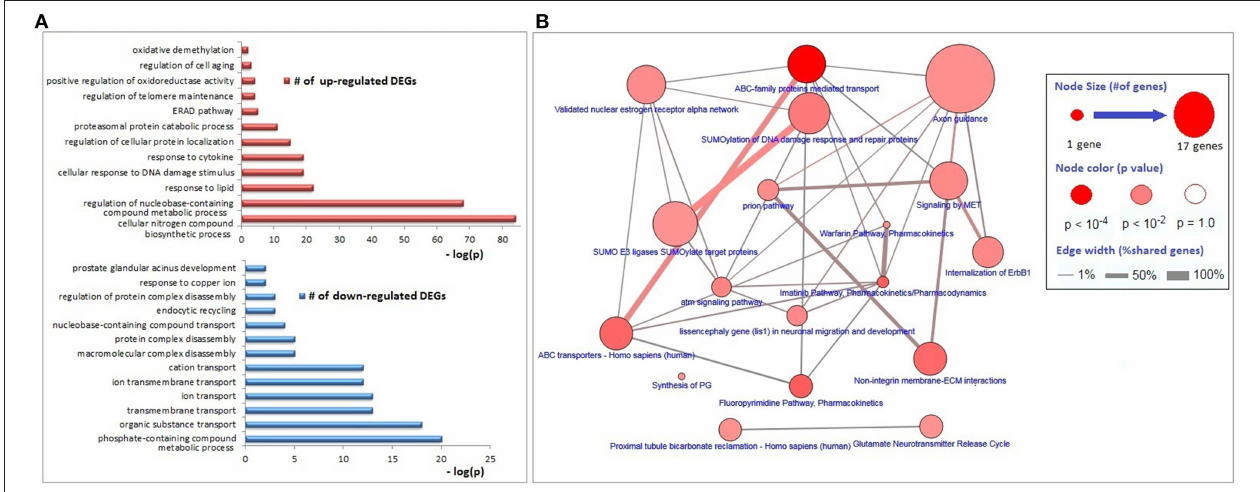
FIGURE 2 | Biological process and pathway enrichments of DEGs. (A) Biological process enrichments of up- and down-regulated DEGs. (B) Pathway enrichments of DEGs.